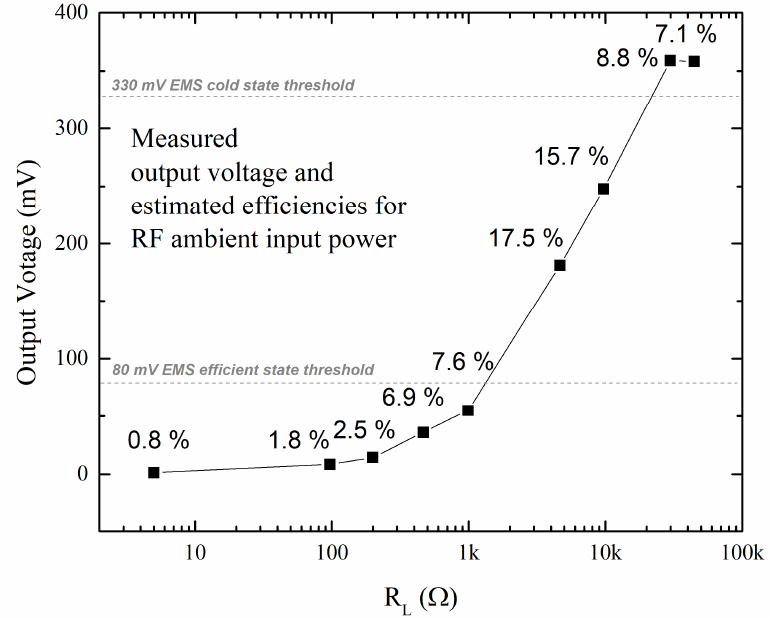
Figure 13. Measured output voltages of the MIMN bridge rectifier system, for different output loads (R L ) using RF ambient as input power. Each point is labeled with the correspondent efficiency estimation.